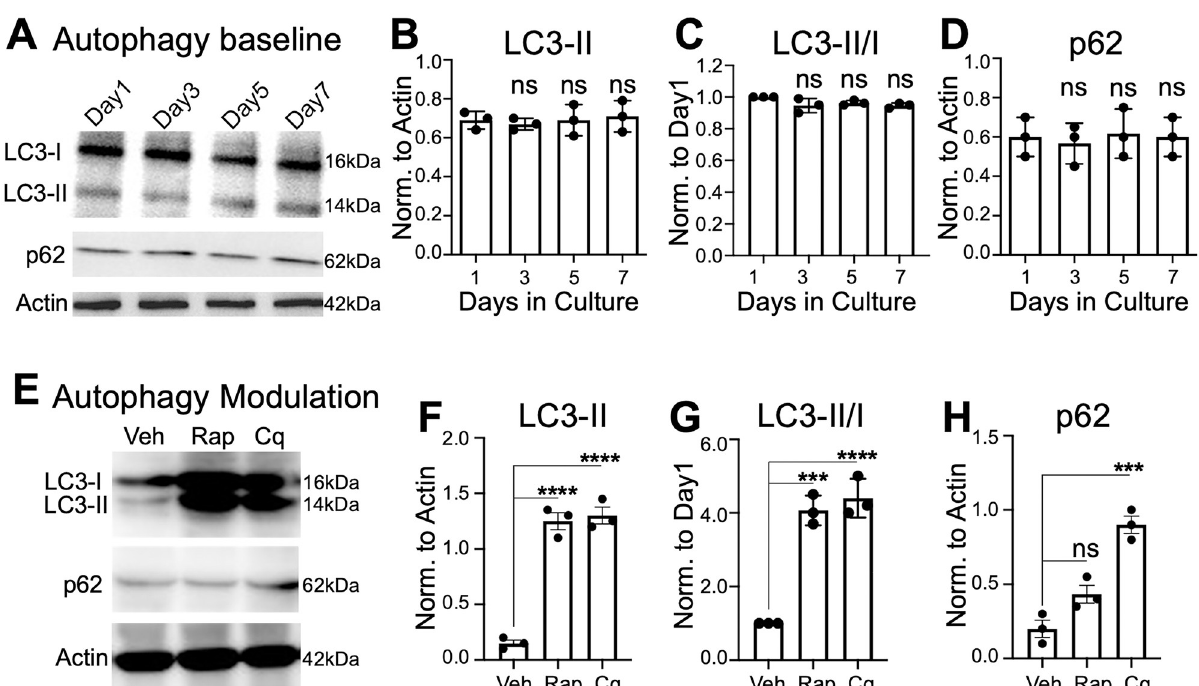
Fig 2. Basal autophagy is preserved in cultured canine cardiac slices. A-D. Representative immunoblots for cardiac slices cultured for 1–7 days. Quantification showed no change in expression of autophagy proteins LC3-II and p62. E-H. Autophagy was induced by 0.1 μ M rapamycin (Rap) or blocked by 20 μ M chloroquine (Cq) for 24 hours. Rapamycin significantly increased LC3-II expression but not p62 compared to vehicle (Veh) control. Chloroquine led to the accumulation of LC3-II and p62. Protein quantifications were normalized to Actin. N = 3, ��� p < 0.001, ���� p < 0.0001, ns = no significant change, ANOVA with Tukey